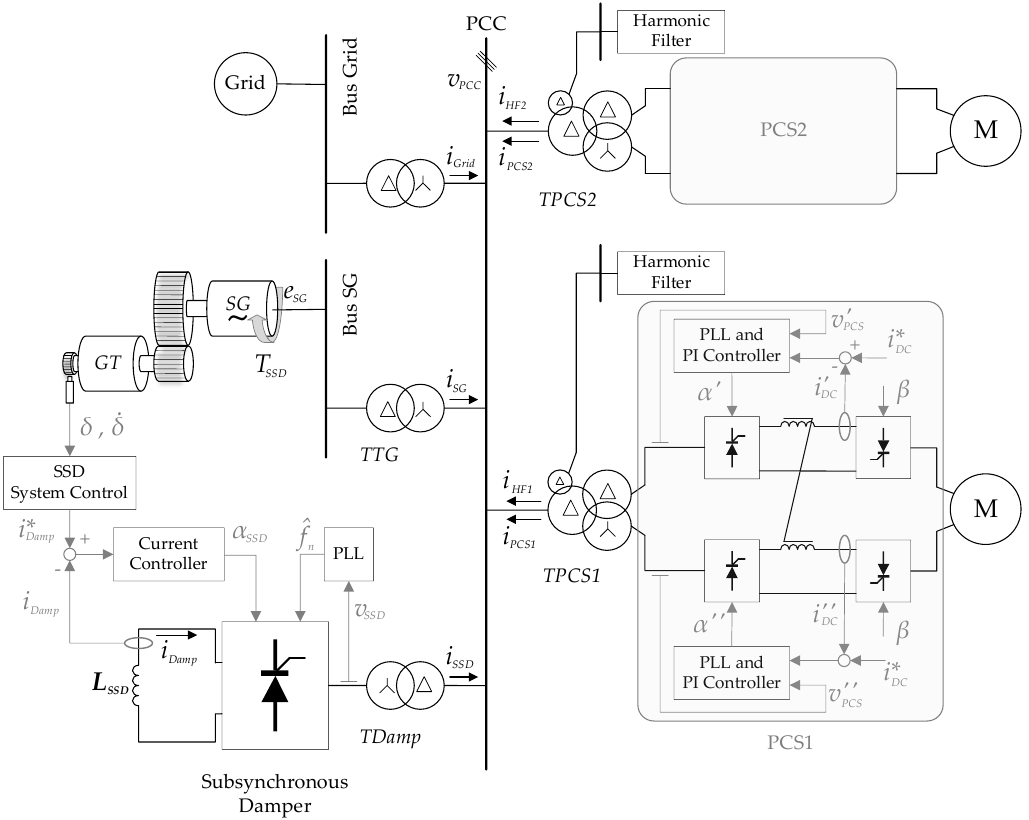
Figure 1. Overall liquefied natural gas (LNG) plant under analysis.